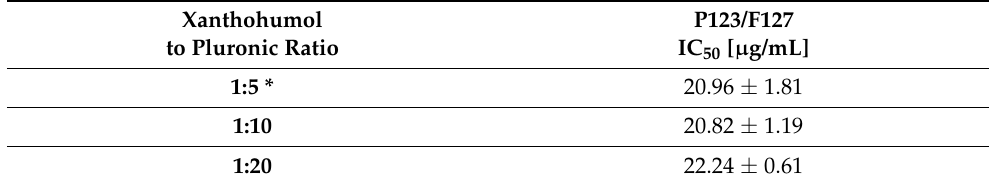
P123/F127 IC 50 [ µ g/mL]